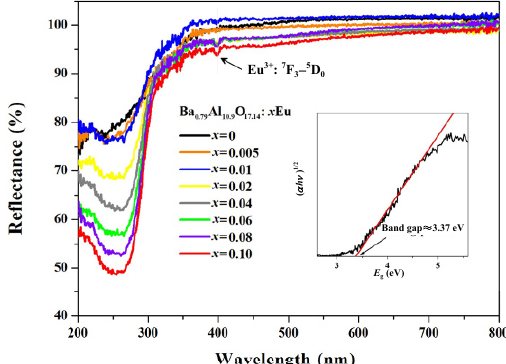
Fig. 4 Diffuse reflection spectra of Ba 0.79 Al 10.9 O 17.14 : x Eu ( x =